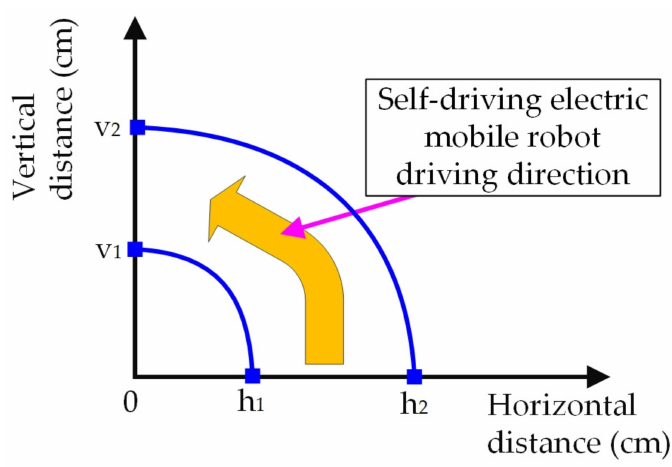
Figure 5. Curve diagram of the self-driving electric mobile robot taking a left